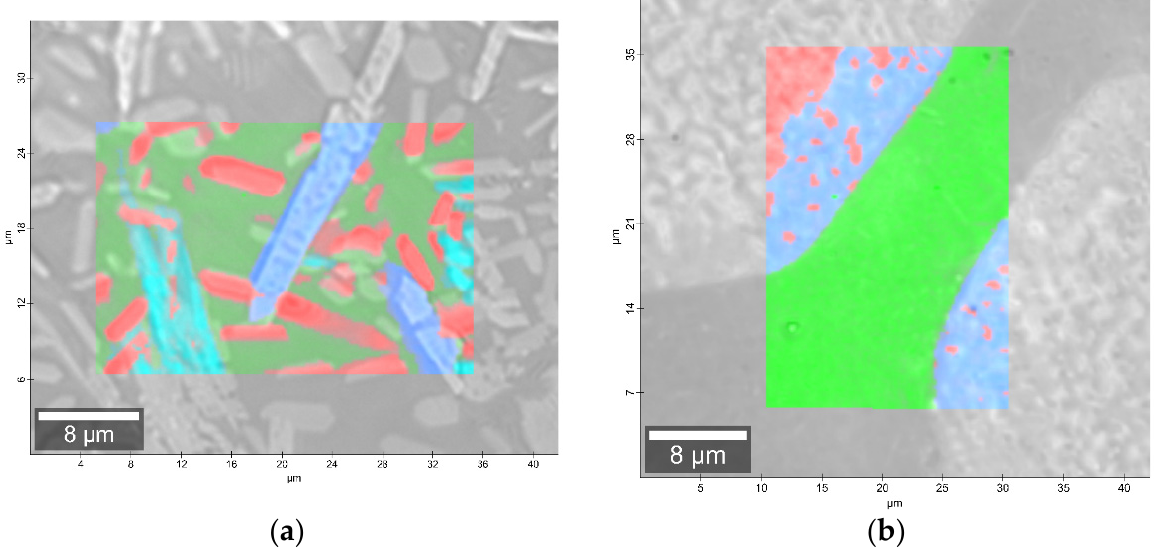
Figure 8. Microscopic images with overlaid Raman images of ( a ) 2B_1007 and ( b ) 20B_710 samples.